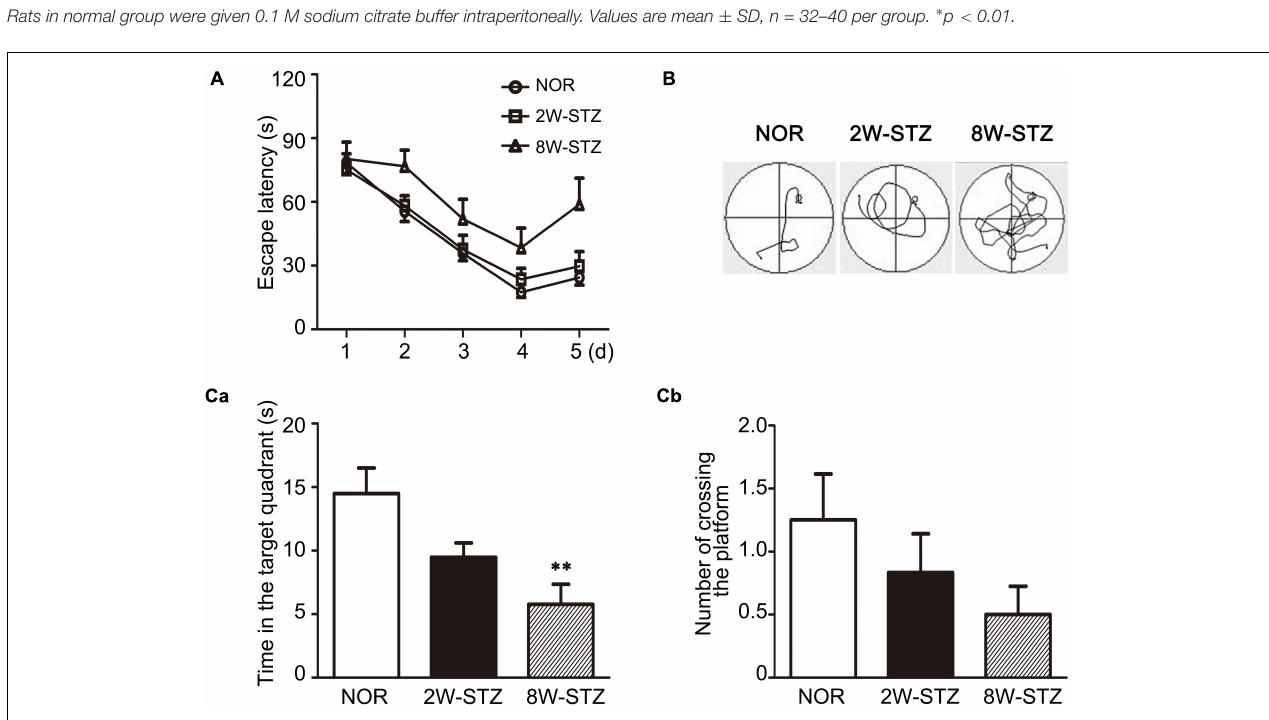
Frontiers in Aging Neuroscience |